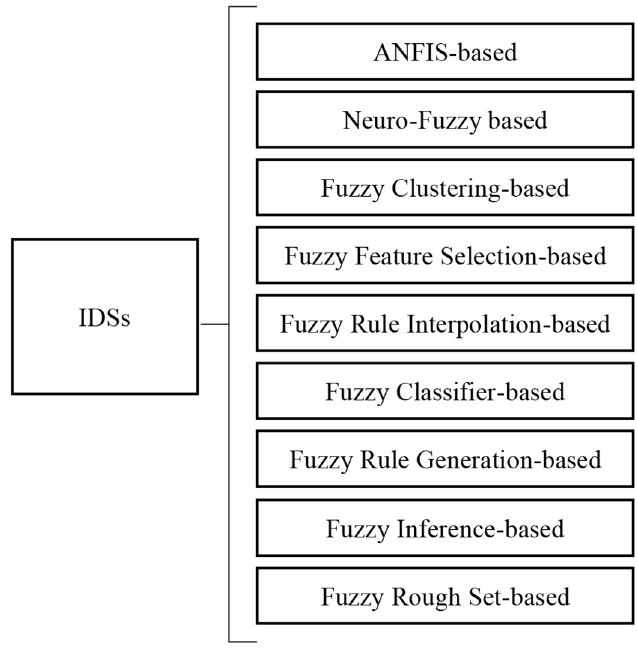
Fig 3. Classification of fuzzy IDSs. The 9 categories of fuzzy intrusion detection schemes according to [29].